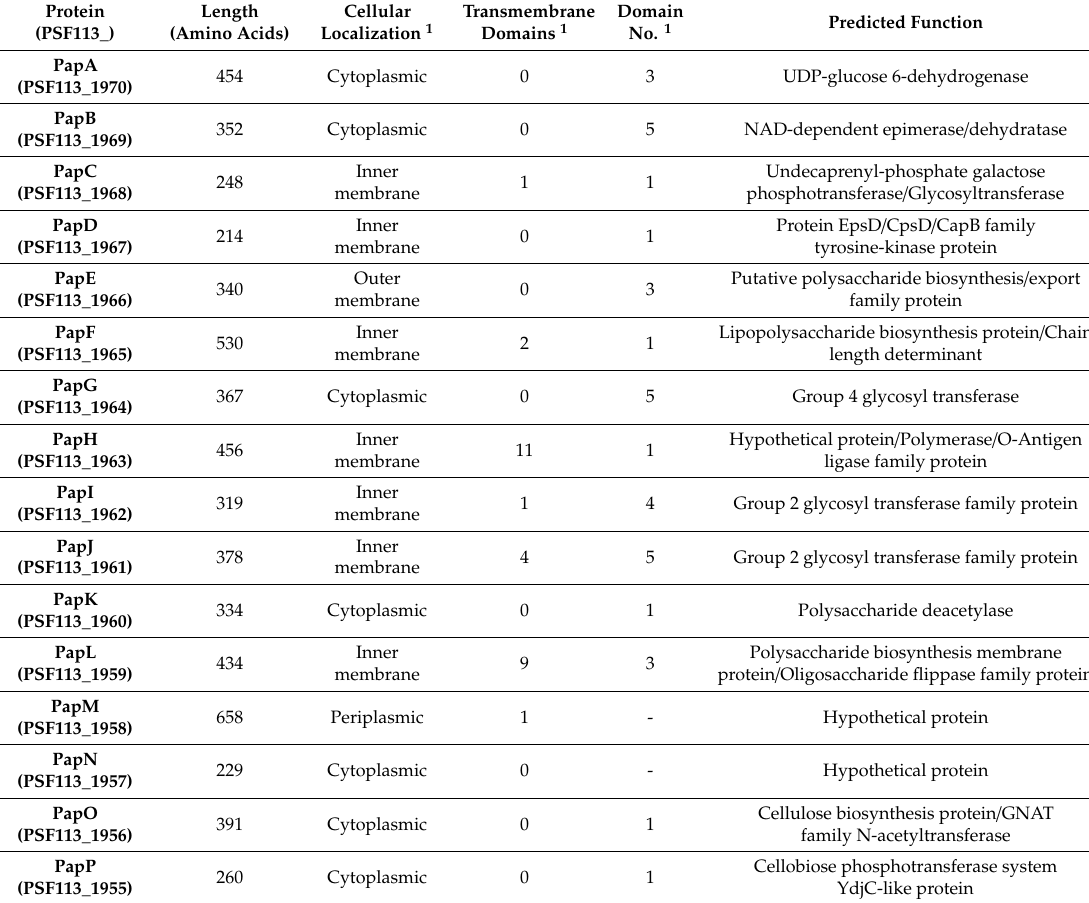
Table 1. Predicted localization, domains, and function for Pap proteins in Pseudomonas fluorescens F113. Protein Length Cellular (PSF113_) (Amino Acids) Localization